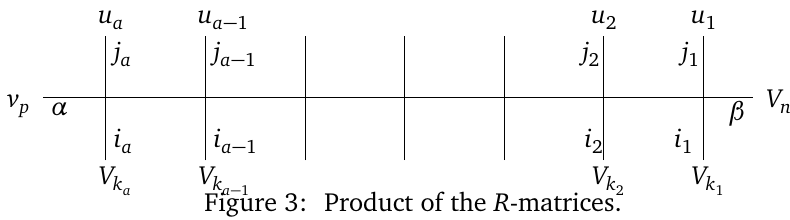
Figure 3: Product of the R -matrices.